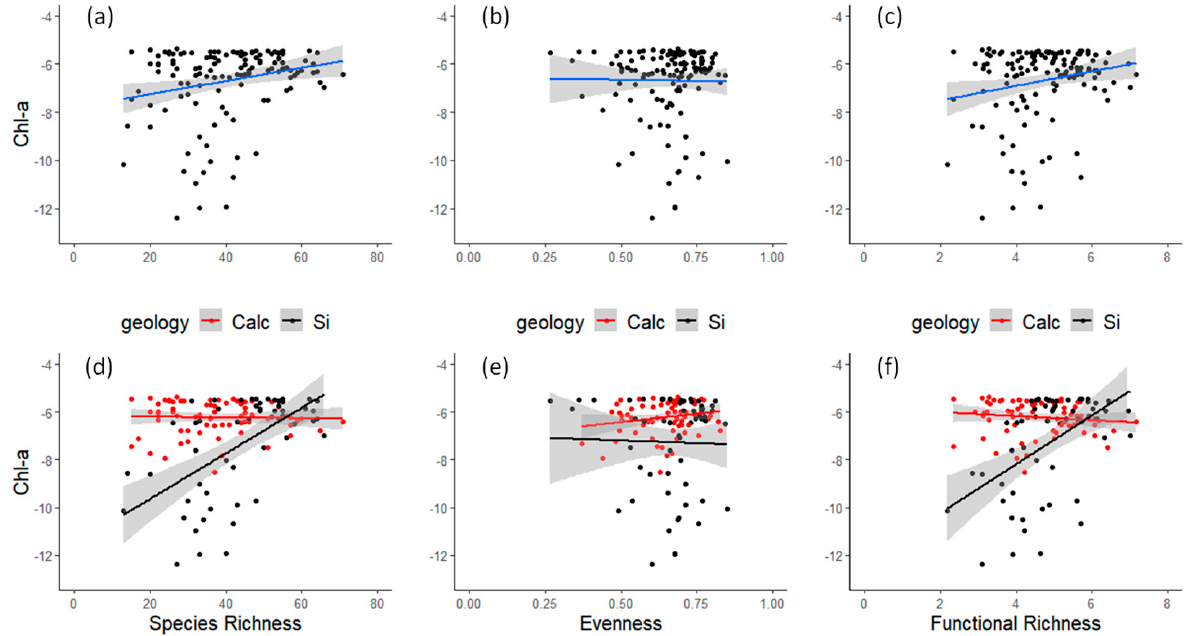
Figure 1. Diversity (expressed as ( a , d ) species richness S, ( b , e ) evenness J and ( c , f ) functional richness) and ecosystem functioning (presented as ln(Chl-a) on y-axis) relationships in each river on the whole dataset ( a – c ) and at different geological substrate levels ( d – f ).